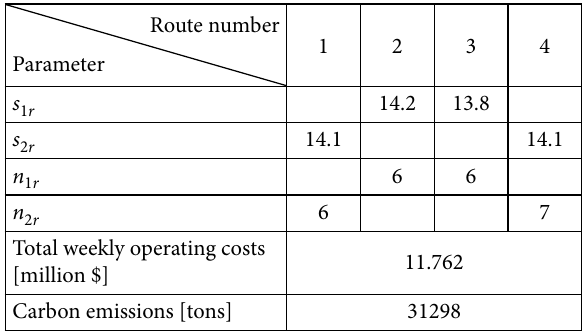
Table 4. The optimization results of